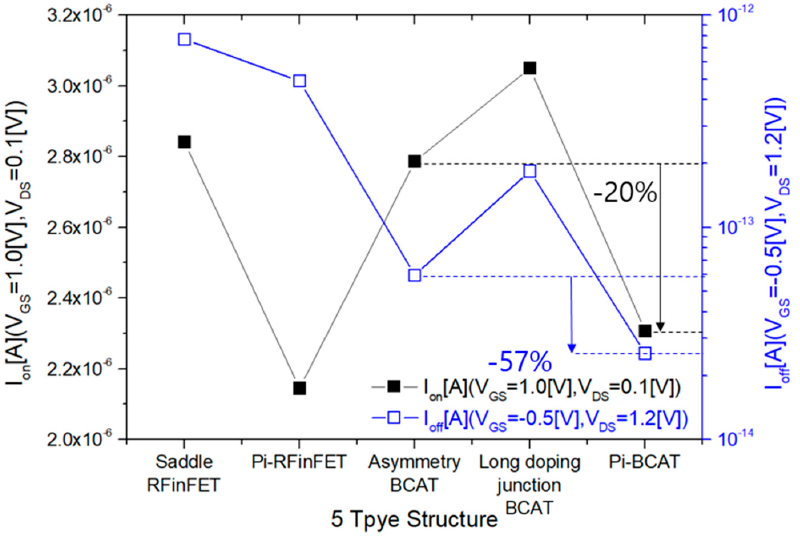
Figure 3. Numerical comparison of on/off current in five structures.